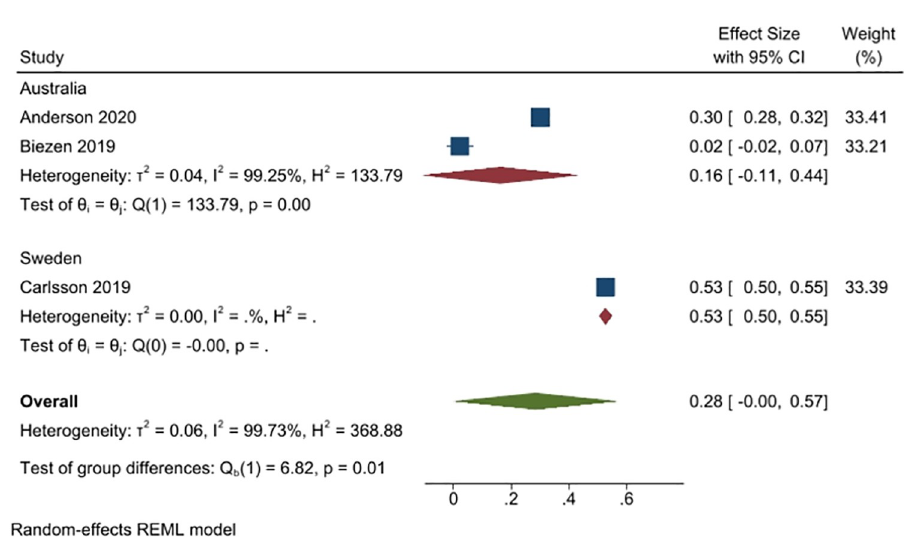
Fig 12. Percentage of respondents answering yes to the question whether they would see another doctor if their doctor did not prescribe an